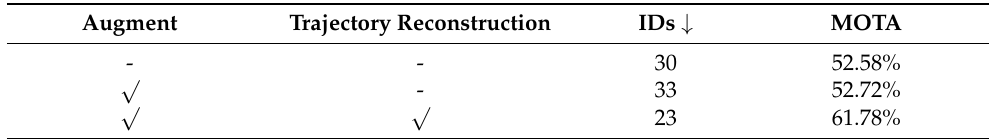
Table 5. Effects of using the elastic-distortion data-augmentation strategy and trajectory-reconstruction module for tracking.